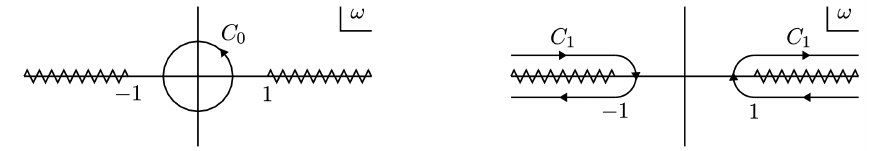
Figure 4: The contour C around the branch